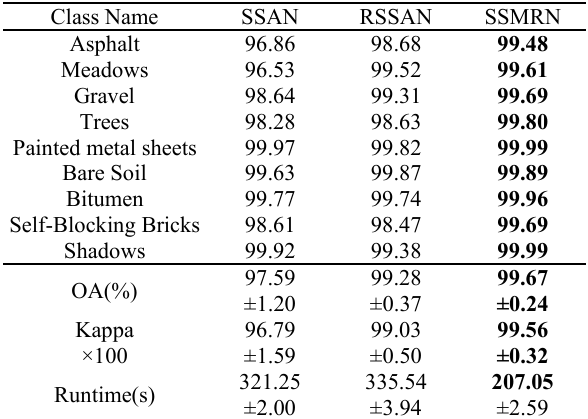
Table 2 . Classification results of different methods for the Pavia University data set. Bold indicates the best result.